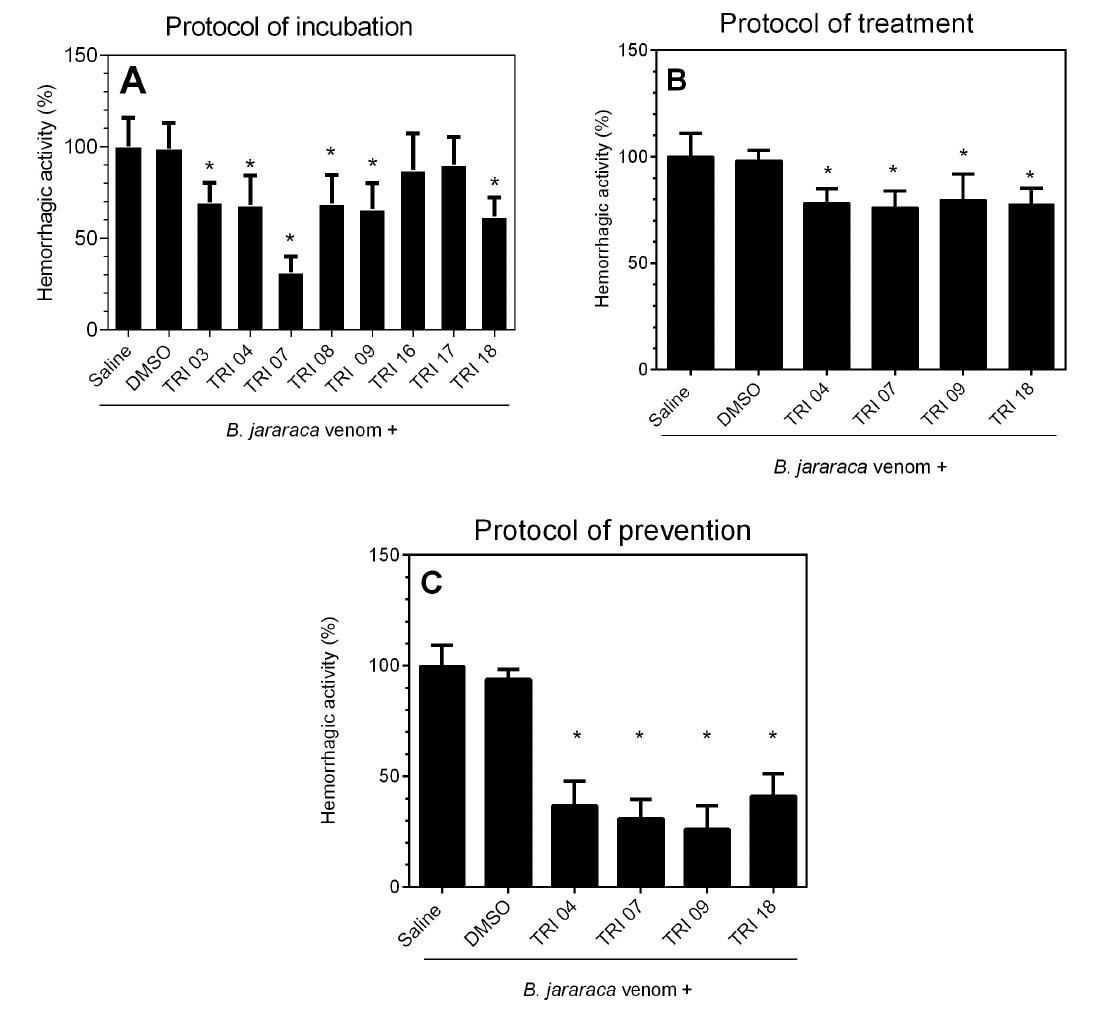
FIGURE 3 - Effect of derivatives on hemorrhaging caused by B. jararaca venom. B. jararaca venom (100 µg/mL) was incubated with saline, DMSO or with 150 µg/mL of derivative (TRI 03, TRI 04, TRI 07, TRI 08, TRI 09, TRI 16, TRI 17, and TRI 18) for 30 min at 25 ºC, and then the mixture was injected s.c. into mice (Panel A, incubation protocol). The derivatives (TRI 04, TRI 07, TRI 09, and TRI 18) were injected s.c. into mice 30 min after (Panel B, treatment protocol) or before (Panel C, prevention protocol) injecting s.c. B. jararaca venom. After the injections, the hemorrhagic halo was measured, and expressed as % of hemorrhage activity. Results are expressed as means ± SD of two + saline or B. jararaca venom +